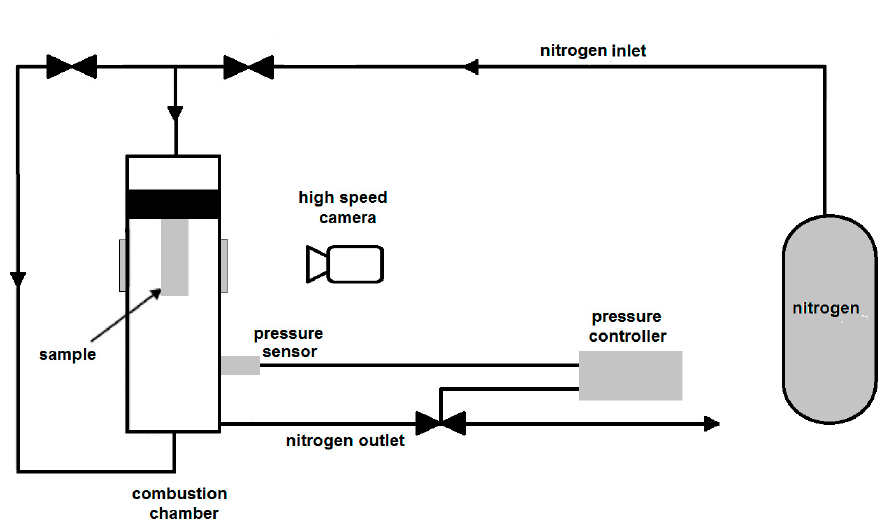
Figure 1. Schematic diagram of the lab-scale strand burner for r b determination setup.